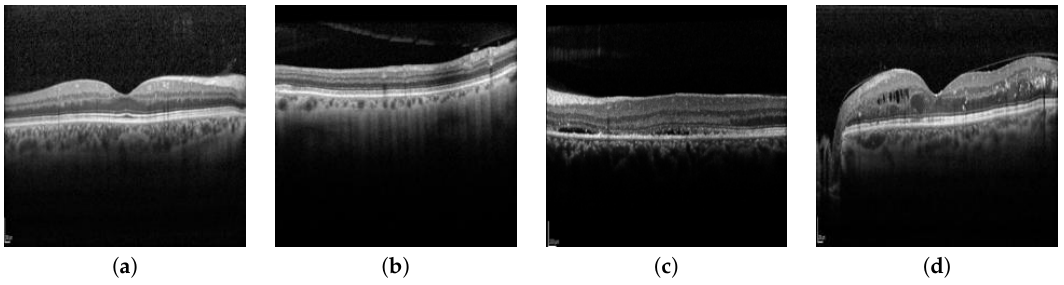
Figure 1. Representative examples of OCT scans. ( a , b ) OCT scans without the presence of DME. ( c , d ) OCT scans with the presence of